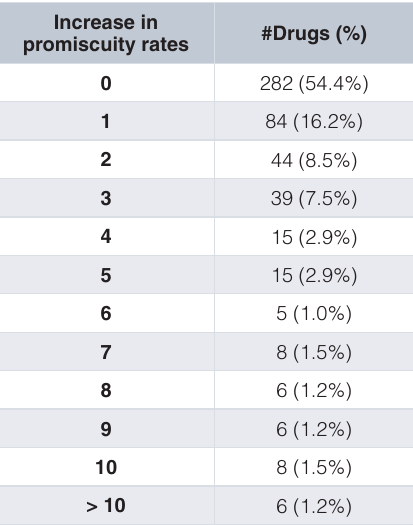
Drugs on a time course